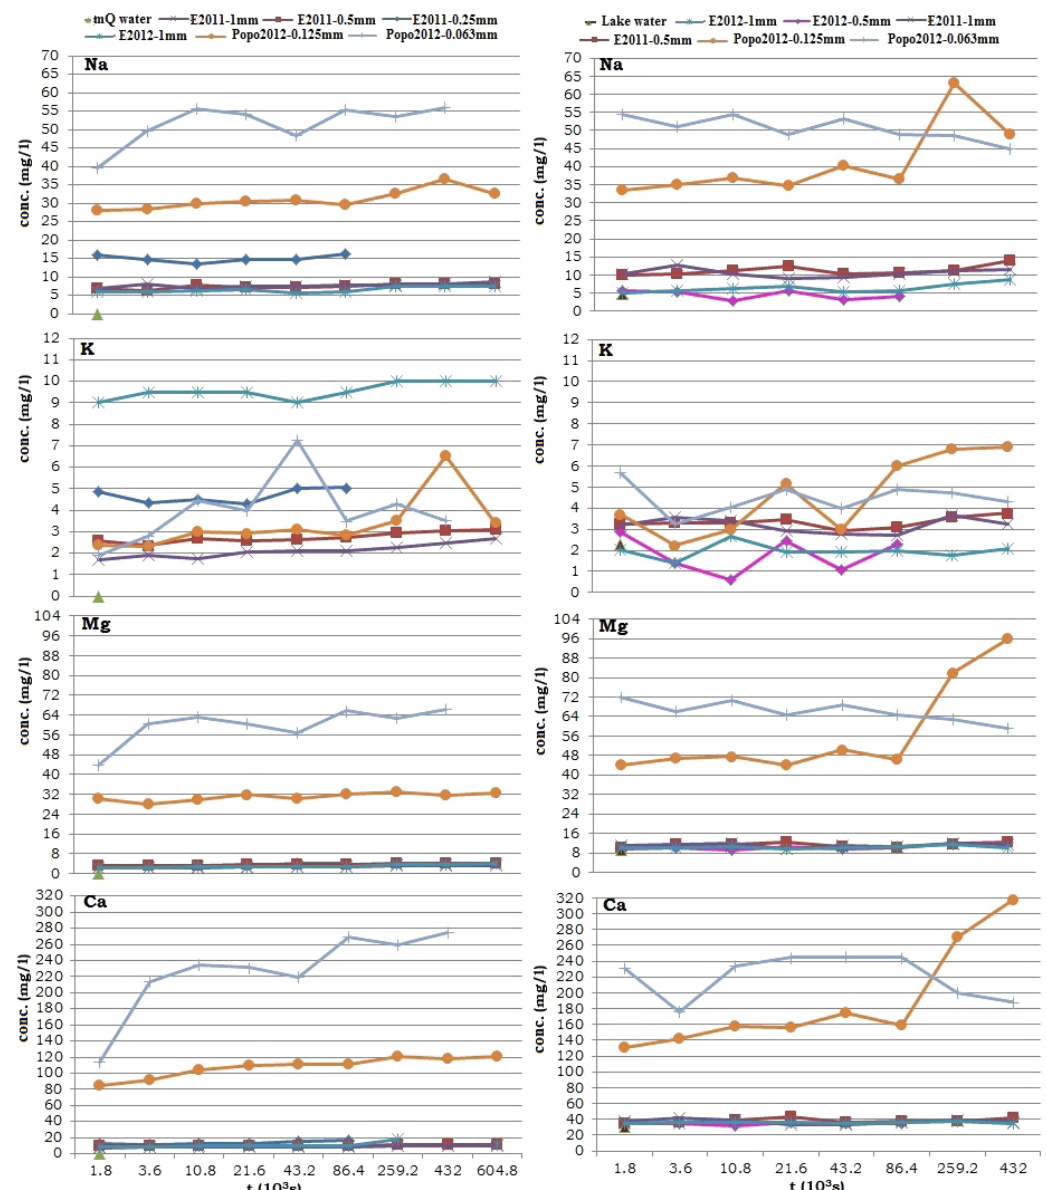
Figure 8. Cations’ (Na + , K + , Ca 2 + , and Mg 2 + ) variation of ash leachates in mQ (left column) and in lake water (right column) for variable stirring times and different grain sizes. The different cations’ contents of mQ and lake water are reported for